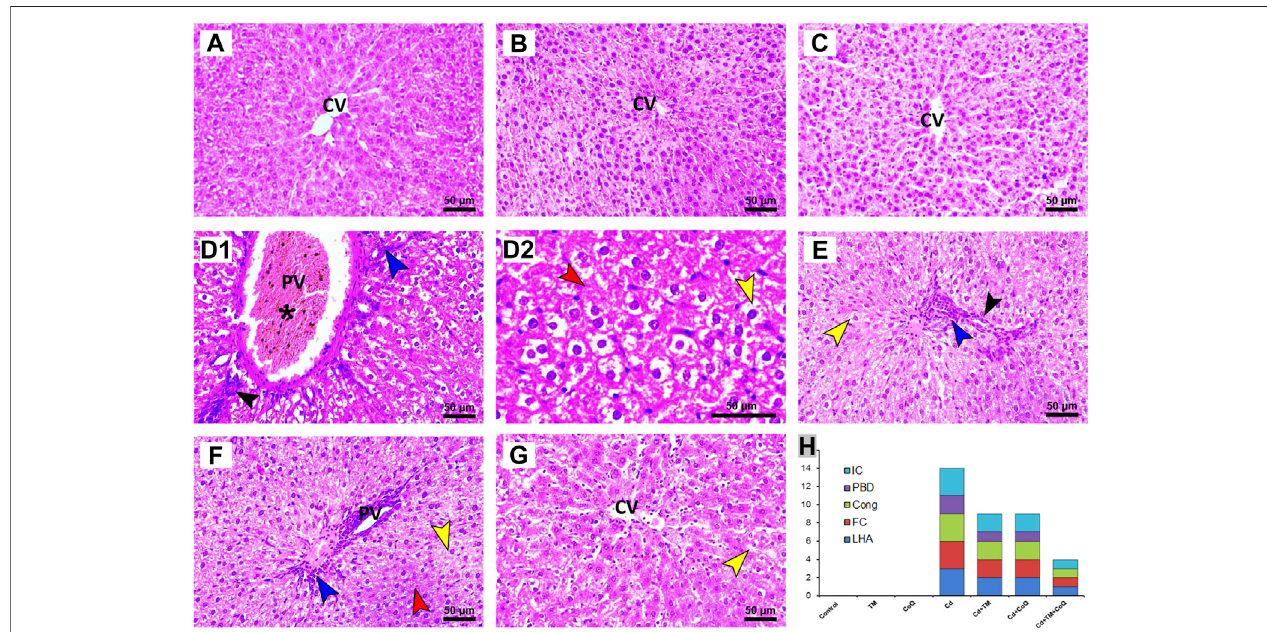
FIGURE5| Histopathology of liver tissue in Control and Cd-, TM-, and CoQ-treated groups. Nearly normal hepatic architectures were observed in Control (A) , TM-treated (B) , and CoQ-treated (C) rats. Cd (D1): liver section of Cd-treated group showing severe congestion of portal vein (asterisk), proliferation of bile duct (black arrow), and dense portal in fl ammation (blue arrow). Loss of hepatic architecture (red arrow) and severe fatty changes were also detected in Cd (D2) . Cd + TM (E) and Cd + CoQ (F): dramatic improvement of hepatic architecture observed when Cd was co-administered with TM or CoQ, indicated by mild fatty changes (yellow arrow), portal in fl ammation (blue arrow), and proliferation of bile duct (black arrow). Cd + TM + CoQ (G): rats treated synchronously with Cd and both TM and CoQ revealed hepatic architecture reverted to normal with very mild fatty changes. (H) Ordinal scoring of recorded histopathological alterations in the liver tissue. (Cong; congestion; CV, central vein; FC, fatty changes; IC, in fl ammatory cell in fi ltration; LHA, loss of hepatic architecture; PBD, proliferation of bile duct; PV, portal vein; scale bar = 50 µM.)